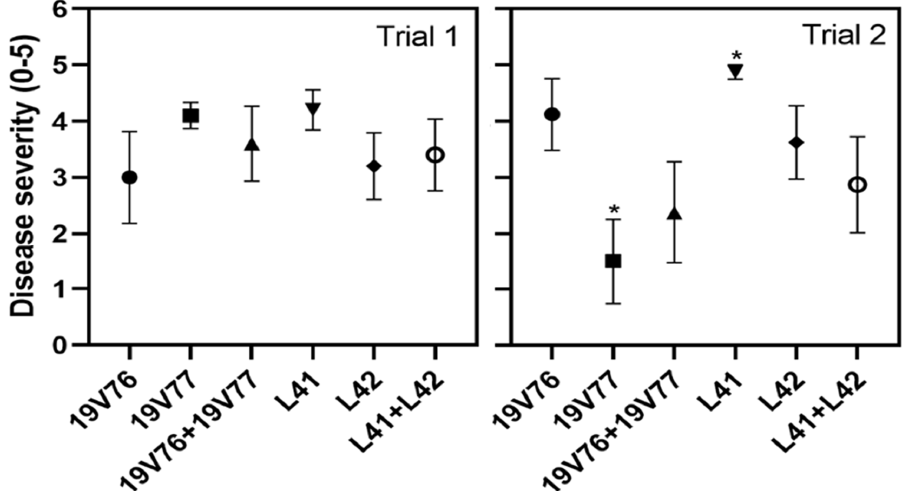
Figure 1. Mean disease severity (0: no symptoms–5: dead plants) recorded at four weeks after root dip inoculation of 2-week-old seedlings either singly or in combination with 10 4 spores/mL suspensions of the tested V. dahliae isolates. Bars represent standard errors of means ( n = 10 and 8 in trial 1 and trial 2, respectively). Asterisks indicate significant differences among treatments ( p = 0.05).